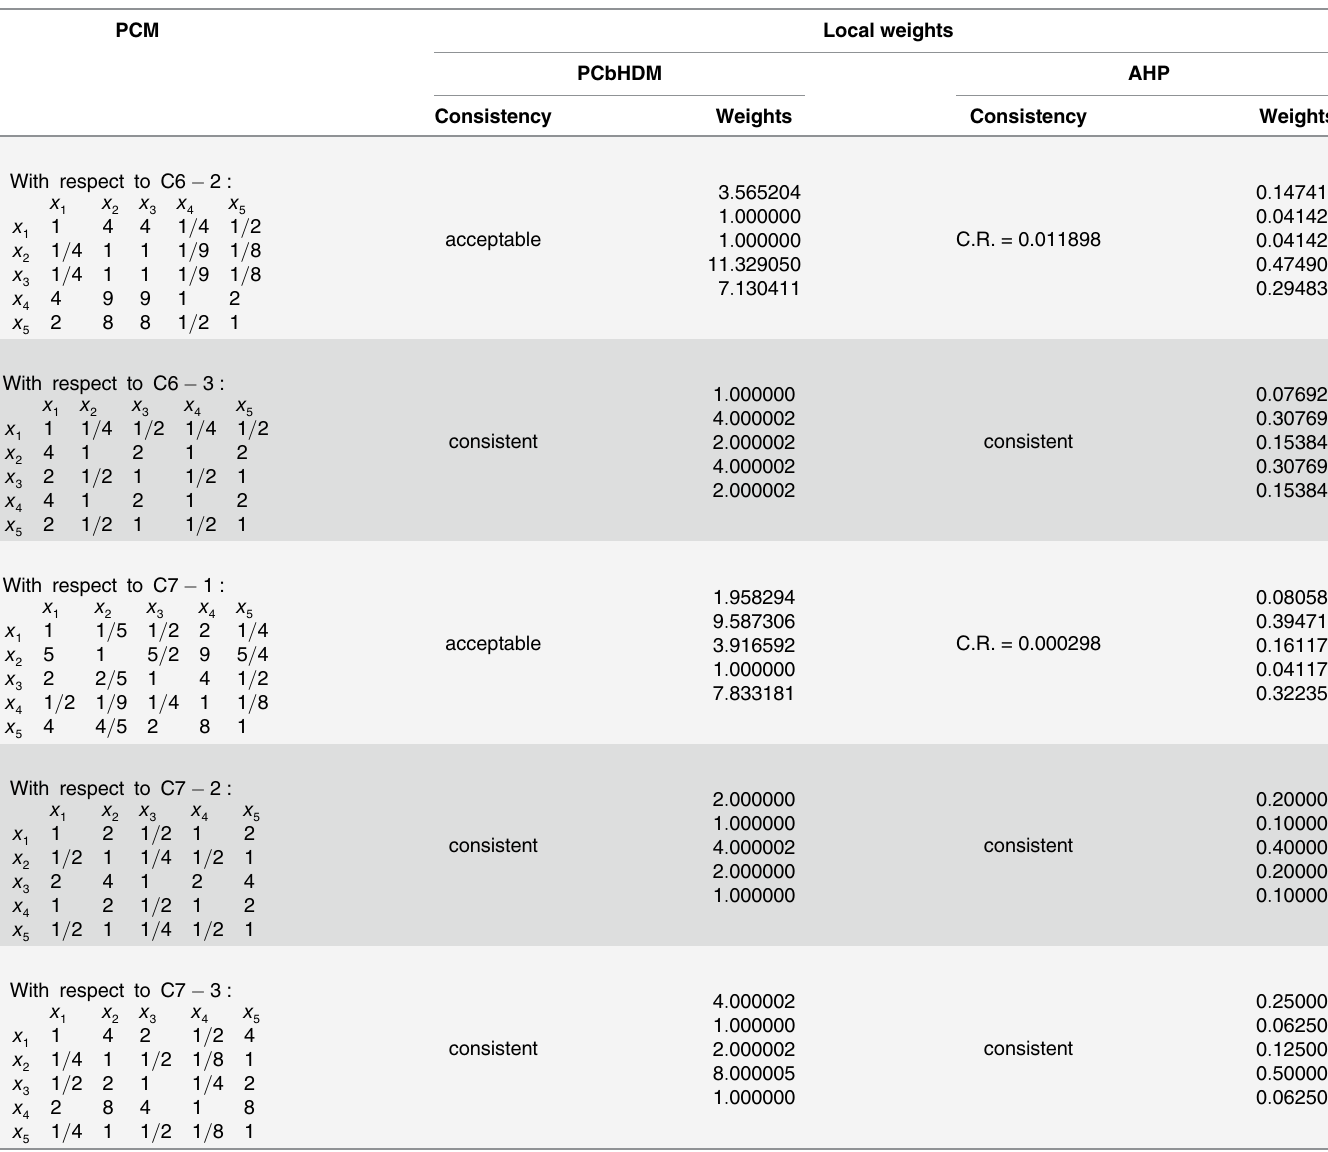
obtained by deleting the 4th rows and the 4th columns of the PCMs contained in Table 4. The PCbHDM gives an overall priorities as: 2.064422, 1.855985, 2.228957, 2.341745,